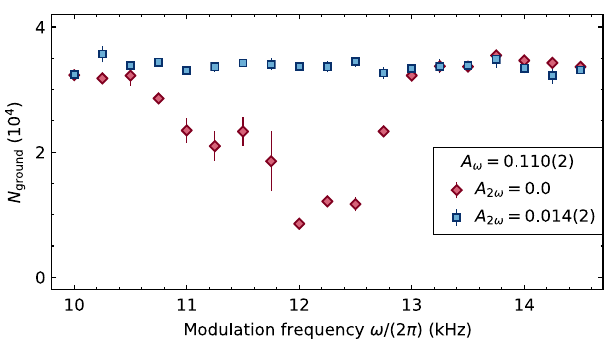
FIG. 7. Dissipation control when being not resonant with higher bands. The lattice is modulated for 20 ms with an amplitude of A ω ¼ 0 . 110 ð 2 Þ using the same configuration as in Fig. 2 in the main text. Without the control drive present (red points), the resonant loss to higher bands leads to a strong depopulation of the ground-band atom number N . When ground adding the control drive at 2 ω with an amplitude A 2 ω ¼ 0 . 014 ð 2 Þ and relative driving phase φ ¼ 0 . 00 ð 2 Þ , keeping the 1 ∶ 2 ratio of frequencies of the Floquet drive and the control drive fixed, destructive interference completely cancels the loss resonance at all measured frequencies (blue points).